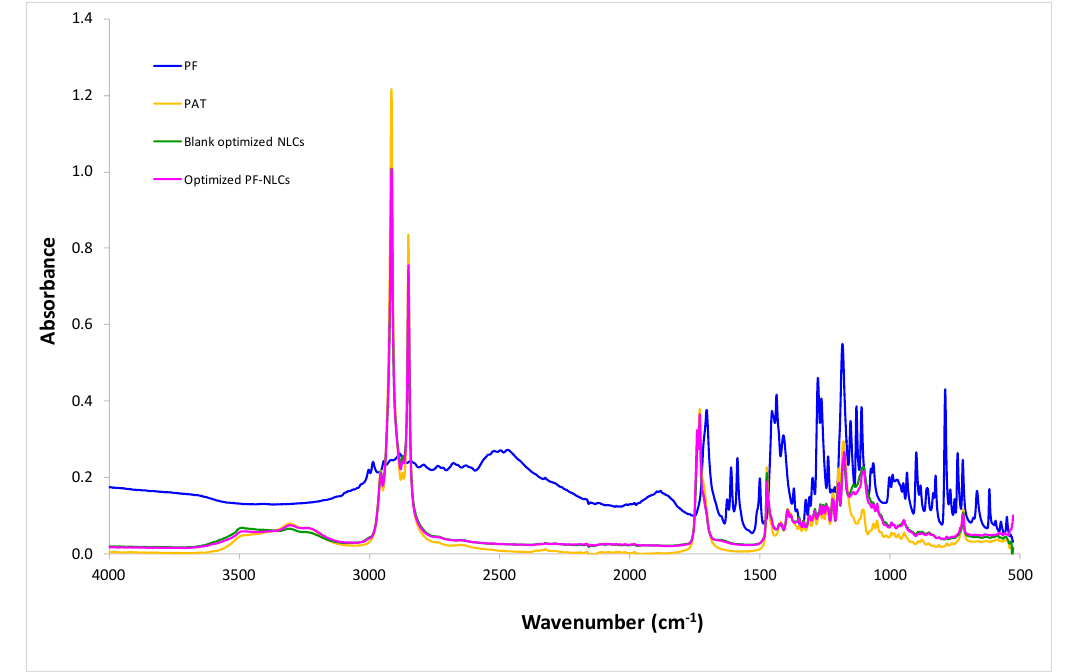
Figure 3. Fourier Transform Infrared (FTIR) analysis.